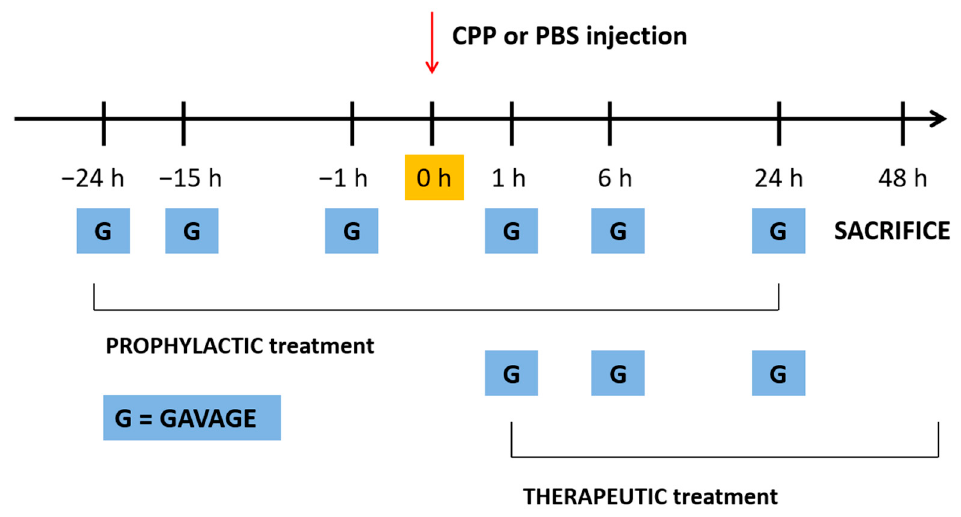
Figure 1. Prophylactic and therapeutic treatment protocols used in the mouse model of calcium pyrophosphate (CPP) crystal-induced arthritis. Gavage (G) time points are described in the figure for the two treatment protocols. In the prophylactic model, polydatin or colchicine have been administered at 24, 15 and 1 h before and 1, 6 and 24 h after crystal injection. In the therapeutic model, drugs have been administered 1, 6 and 24 h after crystal injection. Mice have been sacrificed 48 h after crystal injection.